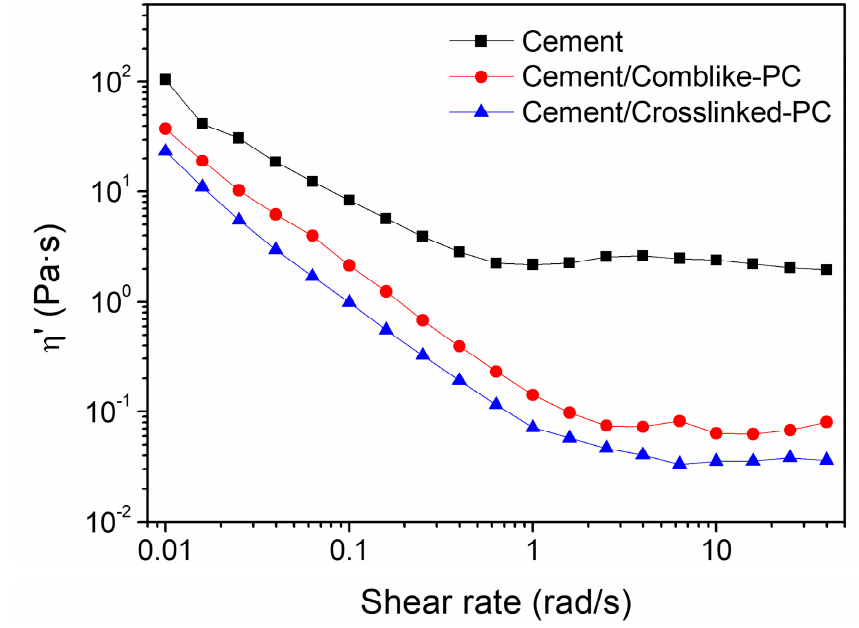
Figure 9. The viscosity η ’ versus shear rate variations in the cement pastes at the PC dosage of 0.5% bwoc.